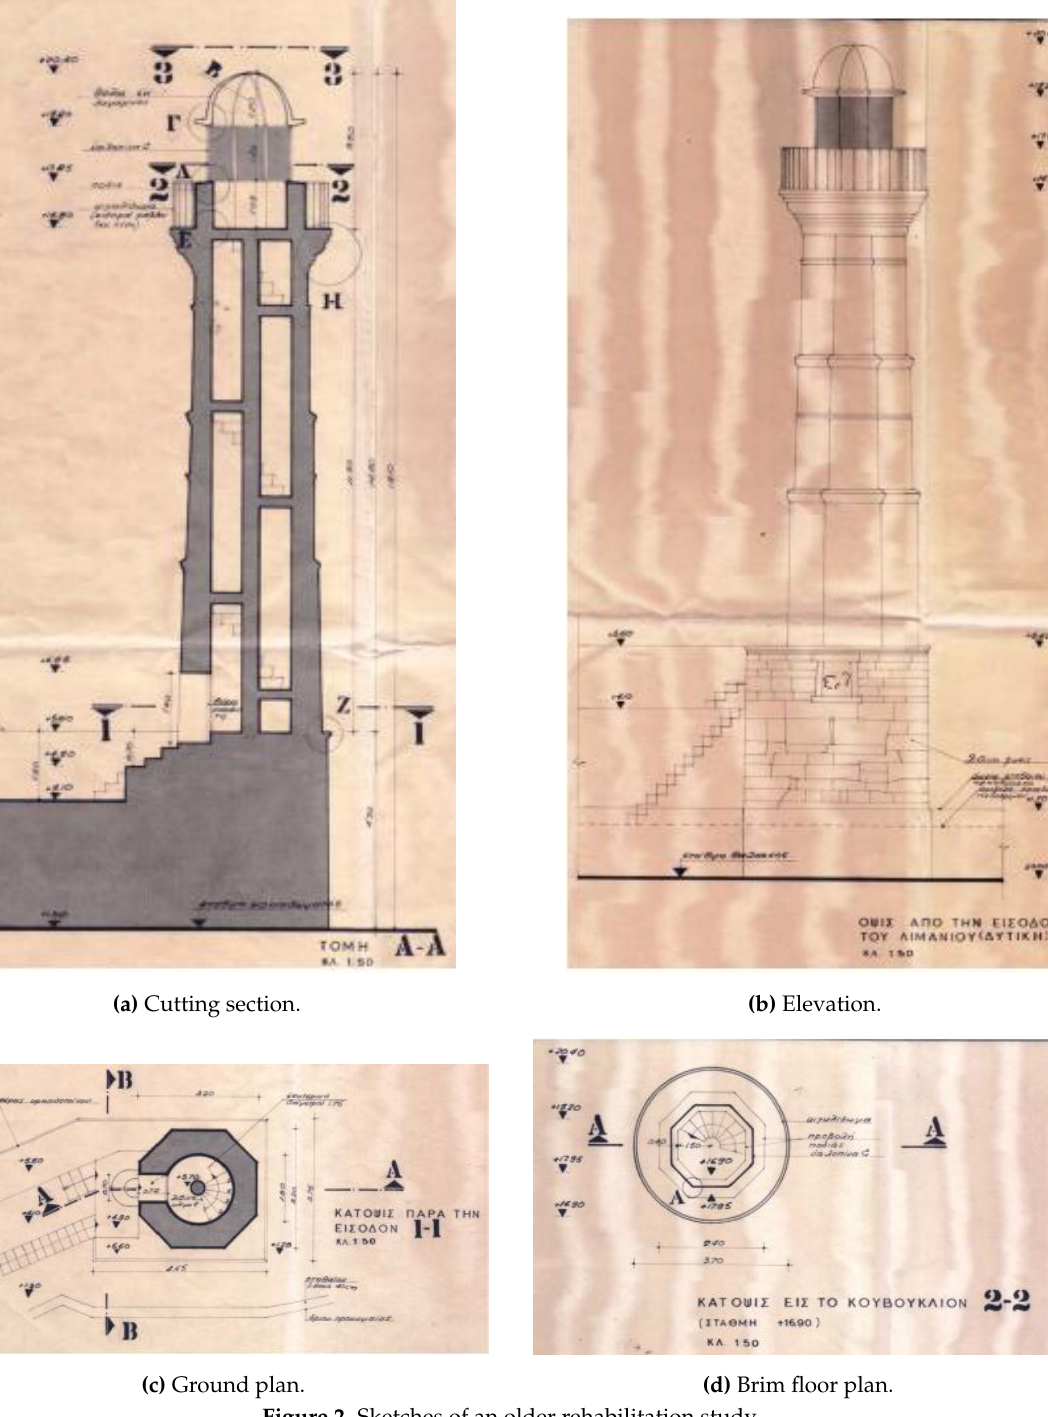
Figure 2. Sketches of an older rehabilitation